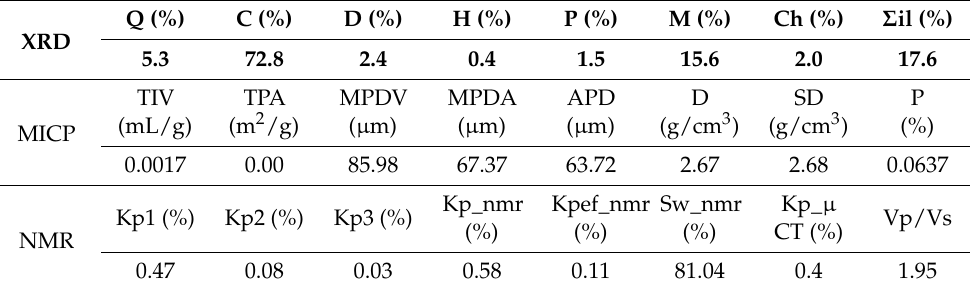
Table 6. Petrophysical parameters of the clayey limestone